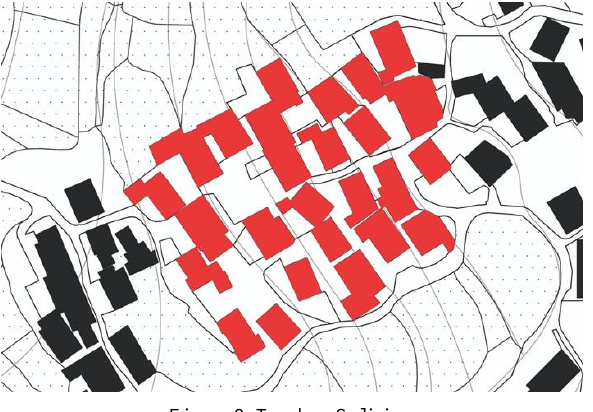
Figure 8. Tandem Splicing.